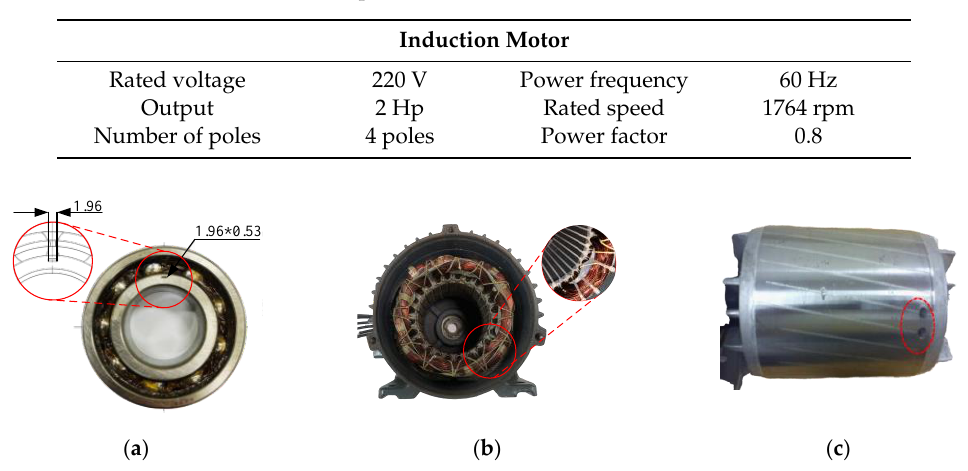
Figure 11. Motor failure sample. ( a ) Bearing of motor (length 1.96 mm and width 0.53 mm); ( b ) Coils of stator (five coils); ( c ) Rotor bar (two holes, diameter: 8 mm and depth: 10 mm).